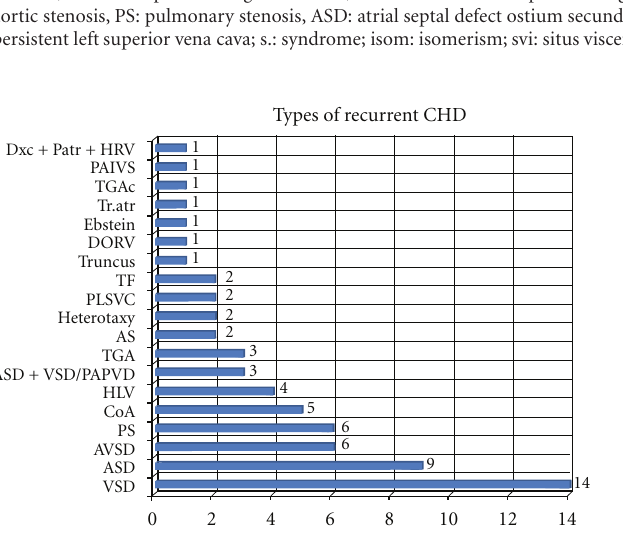
Figure 1: Types of recurrent CHD. Dxc + Patr + HRV: dextrocar- dia + pulmonary atresia + hypoplastic right ventricle, PAIV: pulmo- nary atresia and intact septum, TGA-TGAc: transposition of great arteries, corrected transposition of great arteries, DORV: double outlet right ventricle, TF: Tetralogy of Fallot, PLSVC: persistent left superior vena cava, AS: aortic stenosis, ASD: atrial septal de- fect, VSD: ventricular septal defect, PAPVD: partial anomalous pulmonary venous drainage, HLV: hypoplastic left ventricle, CoA: coarctation of aorta, PS: pulmonary stenosis; AVSD: atrioventricu- lar septal